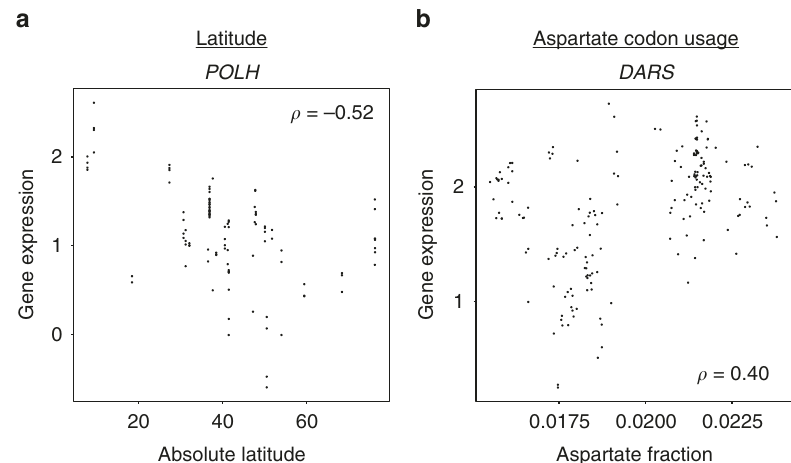
Fig. 4 Associations between expression and other sample information. a Scatterplot of the association between gene expression and the absolute value of latitude for the DNA polymerase POLH . Each point represents one RNA-seq sample. b Scatterplot of the association between expression of the aspartate- tRNA ligase DARS and the abundance of aspartate codons in the coding regions of each sample ’ s